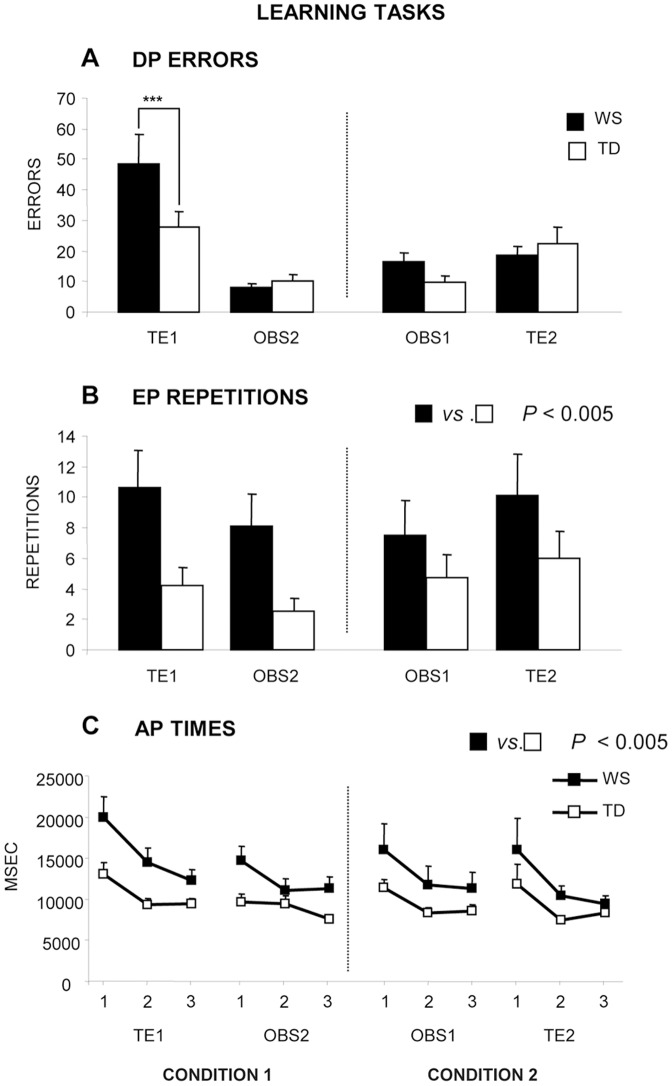
Performances exhibited by WS and TD participants in the two experimental conditions.DP: Detection Phase; EP: Exercise Phase; AP: Automatization Phase. Data are expressed as mean ± SEM. The asterisks indicate the significance level of post hoc comparisons between groups (***P<0.001).